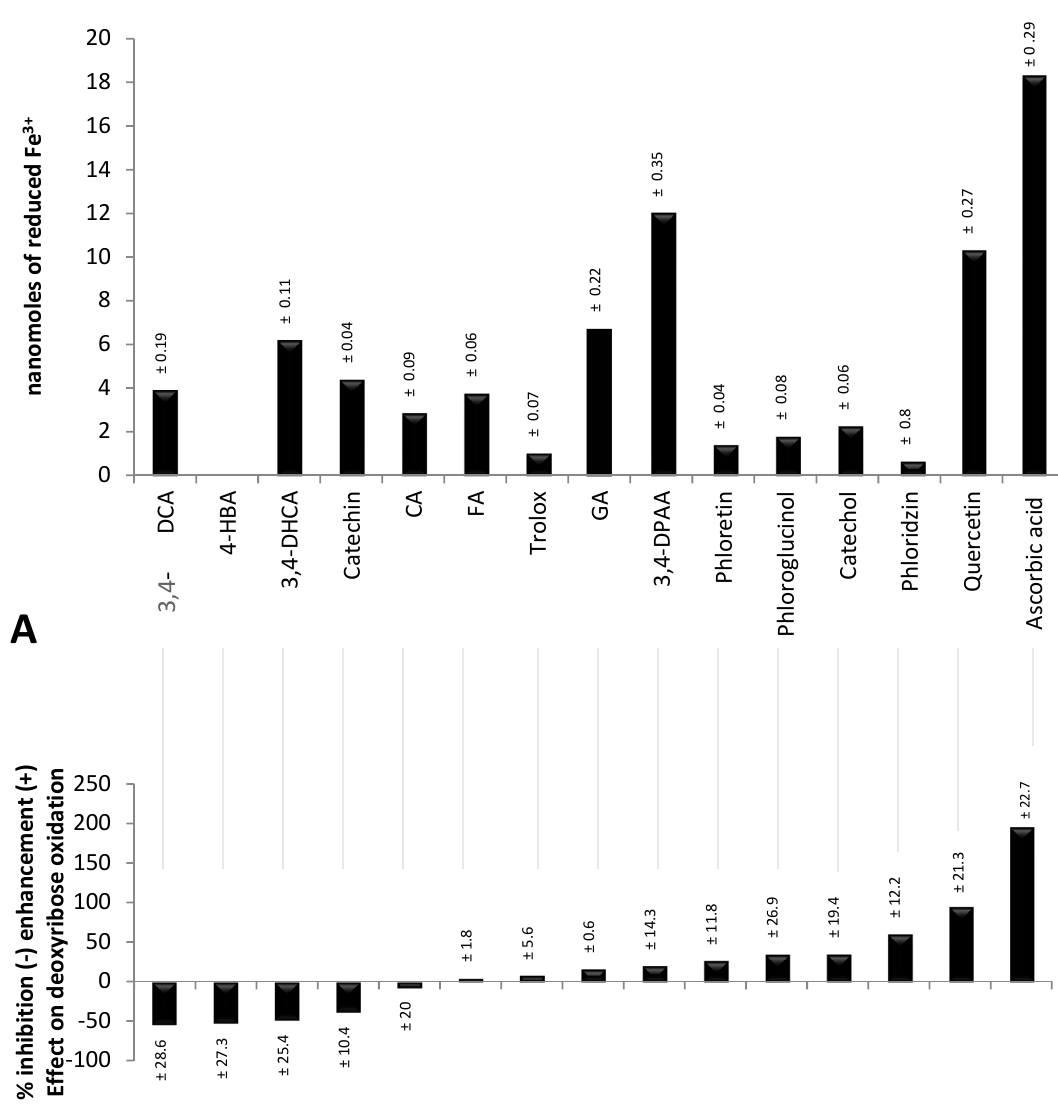
Figure 1. ( A ) nanomoles of reduced Fe 3+ by polyphenols, TROLOX ® and ascorbic acid at a concentration of 5 µ mol/L. 4-HBA observed no FRAP at this concentration; ( B ) percentage of inhibition (expressed as a negative value) and enhancement (expressed as a positive value) of deoxyribose oxidation by polyphenols in a concentration of 10 µ mol/L. Deoxyribose oxidation was induced by a chemical system Fe 2+ -EDTA-H 2 O 2 ; 3,4-DCA—3,4-dihydroxycinnamic acid, 4-HBA—4-hydroxybenzoic acid, 3,4-DHCA—3,4-dihydroxyhydrocinnamic acid, CA—chlorogenic acid, FA—ferulic acid, GA—gallic acid, 3,4-DPAA—3,4-dihydroxyphenylacetic acid, EDTA—ethylenediaminetetraacetic